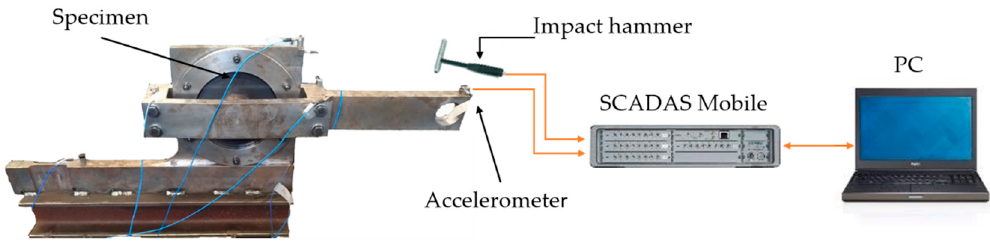
Figure 1. The experimental test set-up for impact hammer modal testing.